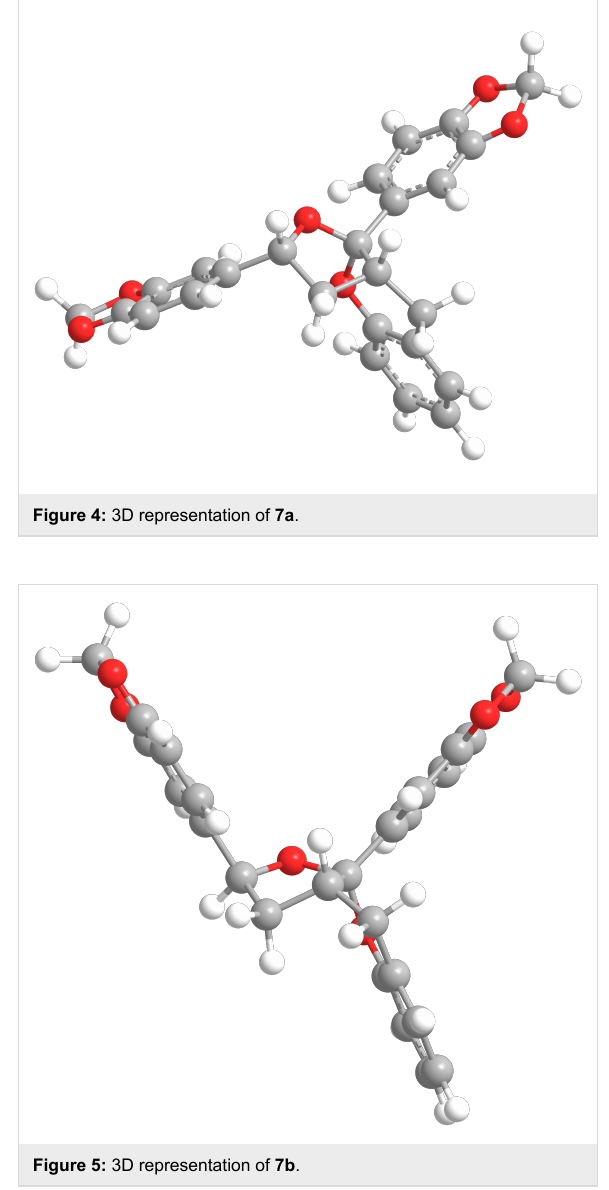
Figure 5: 3D representation of 7b